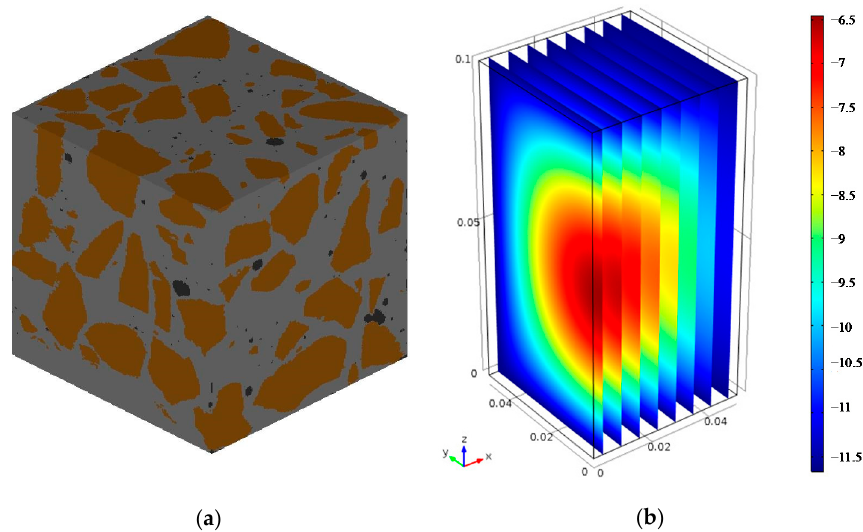
Figure 3. ( a ) The reconstructed three-dimensional structure; ( b ) The temperature field distribution.